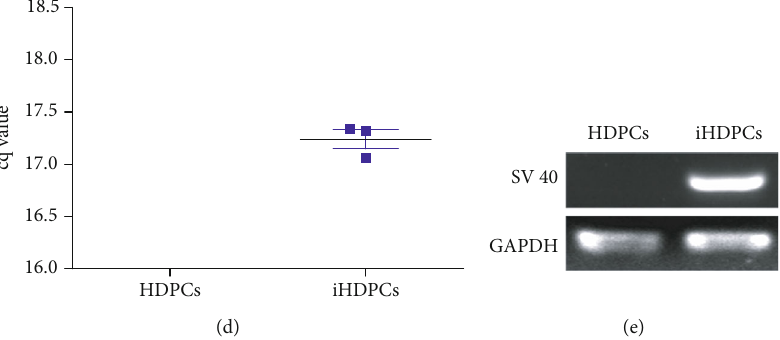
Figure 1: Immortalization of human dental pulp cells using the piggyBac transposon system. (a) Schematic diagram of pMPH86. The SV40 T-Ag gene is located between two fl ippase recognition target (FRT) sites. (b) Schematic of the experimental approach. (c) IHDPC establishment. The adenoviral vectors AdpBase and pMPH86 transfected the primary human dental pulp cells, and cells were selected in medium with hygromycin for 3 days. Surviving cells were observed at day 3, day 7, and day 13 postselection. The iHDPCs passaged consecutively for 25 passages (p25) (d and e). The mRNA expression of SV40T-Ag was upregulated after